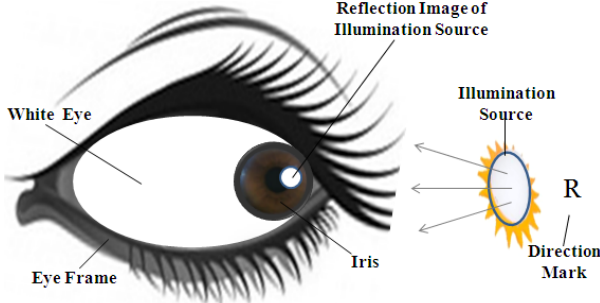
Fig. 1. Schematic diagram of the askiatic imaging